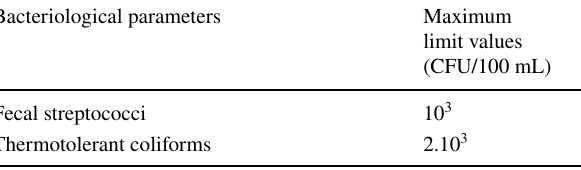
Table 2 Maximum limit values and specific data for discharges of effluent, spills or deposits of any kind that do not pose a risk of tox- icity or nuisance in the hydraulic public domain (Ministry of water resources and the environment of Algeria JORA n°30, 2013: Benya- goub et al. 2018a)